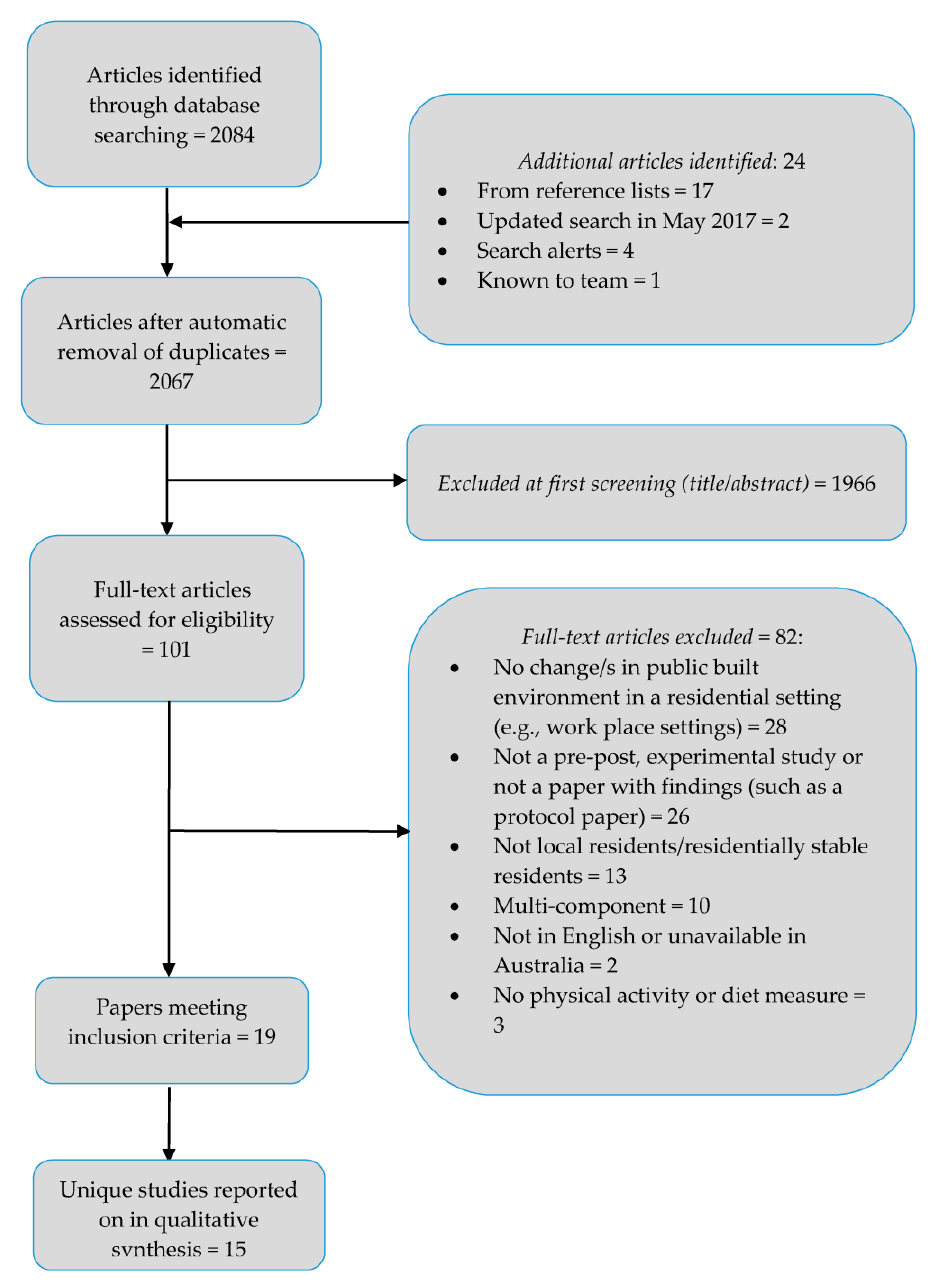
Figure 1. Flow diagram of study selection.